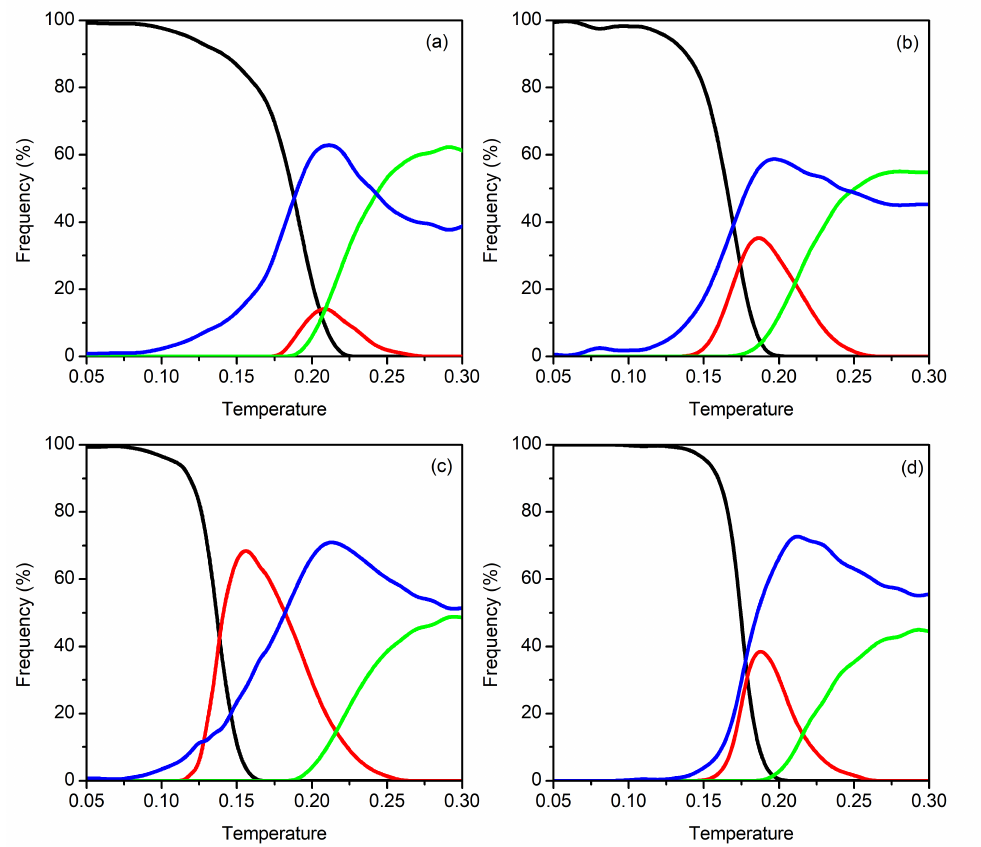
Figure 4. Frequency of the structural motifs as a function of temperature: ( a ) N = 9; ( b ) N = 10; ( c ) N = 11; ( d ) N = 12. Besides low-frequency miscellaneous motifs (blue), lines corresponding to other sets of structures, as defined in Figure 3, are also indicated: Set I (black); Set II (red); Set III (green). At a given temperature, 100% frequency is obtained when summing up the corresponding values for Set I, Set II, Set III and miscellaneous